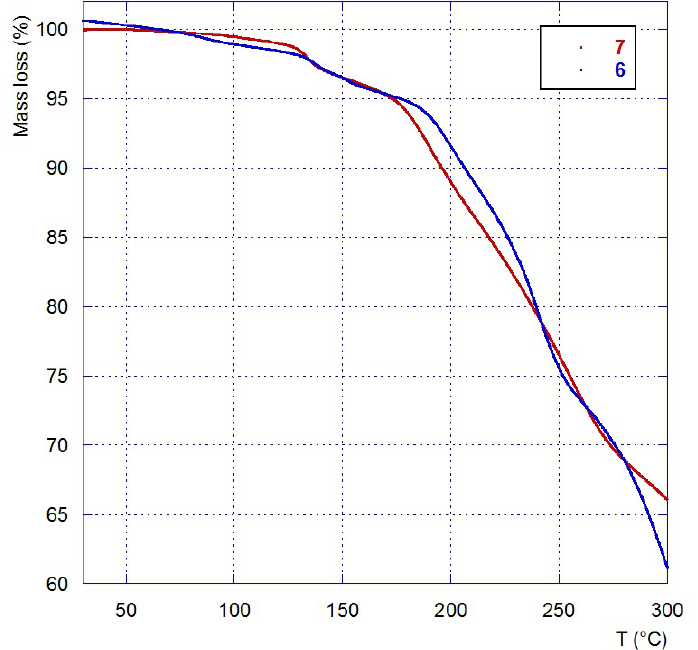
Figure 4. Thermogravimetric analysis of compounds 6 and 7